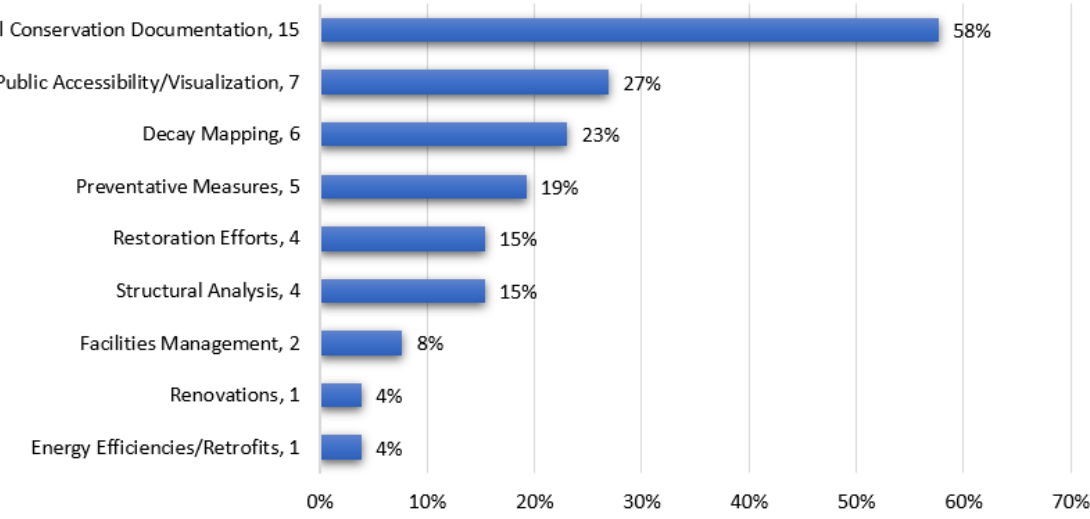
Figure 6. Frequency of primary objectives of 26 HBIM case studies published between 2018–2022. Note: Most cases have multiple objectives.